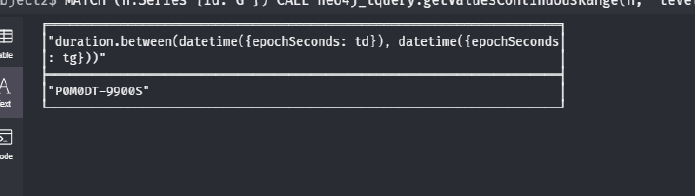
Figure 12. Visualization of the output of query Q 8 run on the sensor network of Figure 4. The result is taken from the web interface of